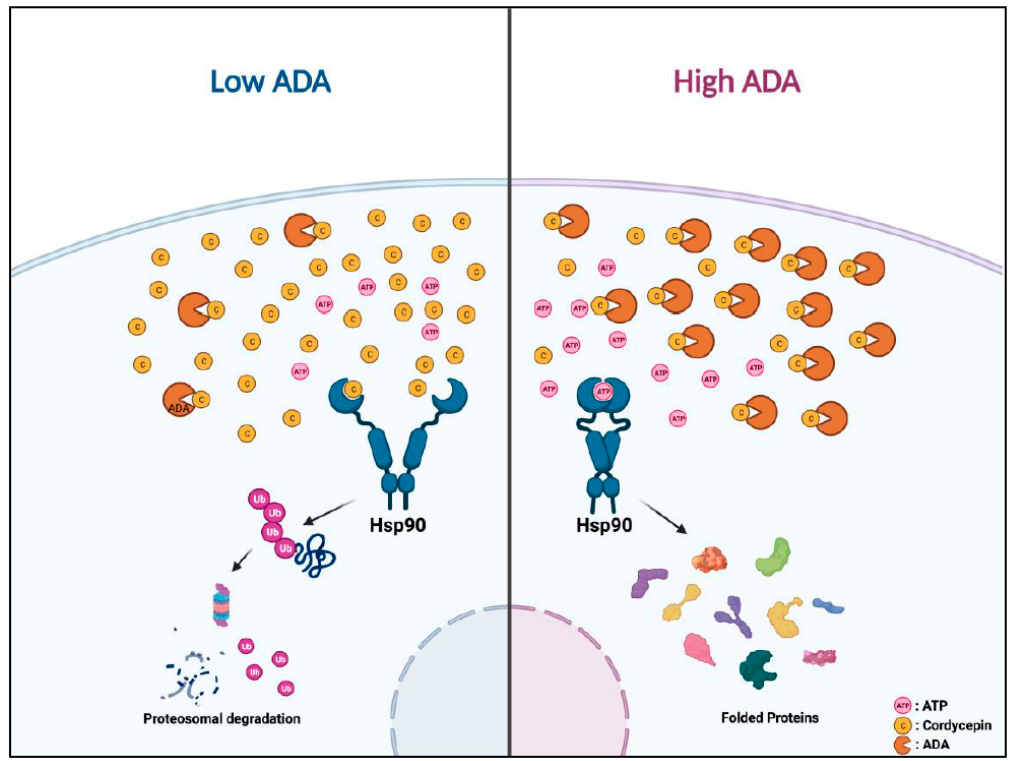
Figure 7. Graphical abstract for the action mechanism of cordycepin. Proposed mechanism of action.